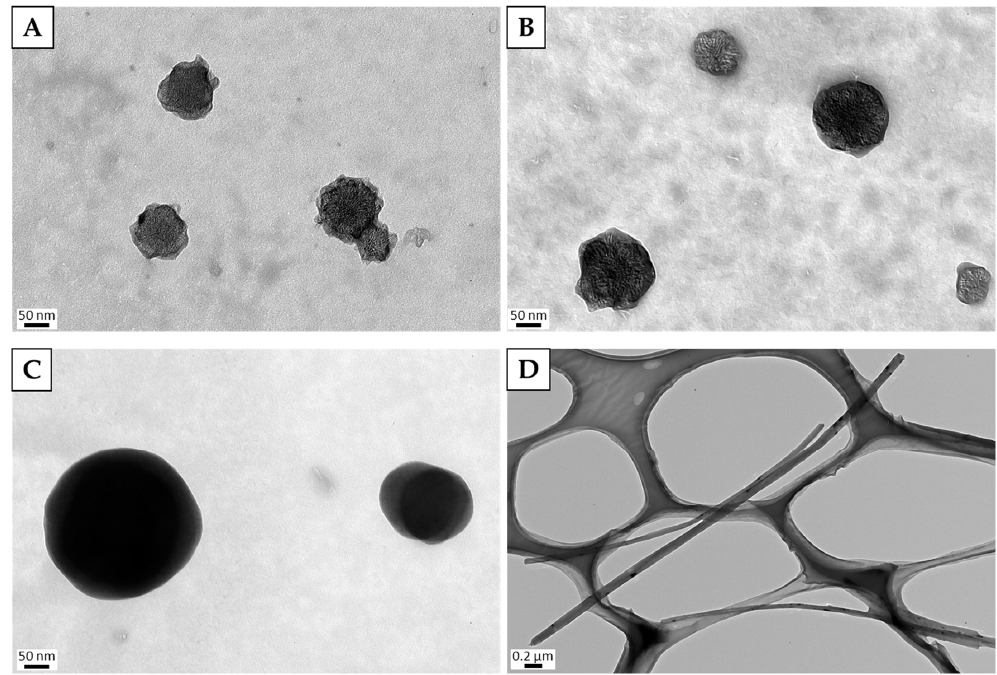
Figure 1. TEM images of carbon nanomaterials dispersed by sonication for 1 h. ( A ) unCNHs, ( B ) oxCNHs, ( C ) CB, ( D ) MWCNTs. TEM, transmission electron microscope; unCNH, untreated carbon nanohorns; oxCNHs, oxidized carbon nanohorns; CB, carbon black; MWCNTs, multi-walled carbon nanotubes.